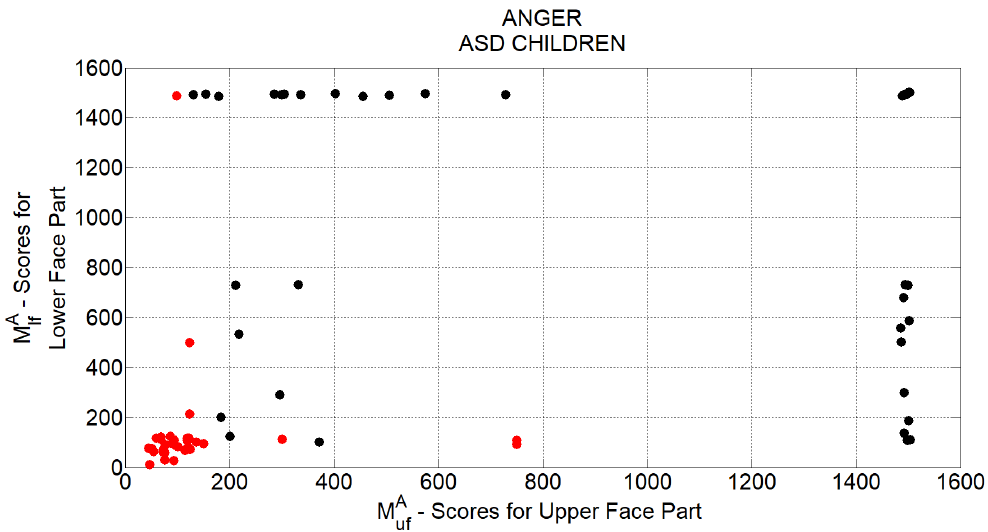
Figure 11. Scores computed for the production of Anger expressions by ASD children.